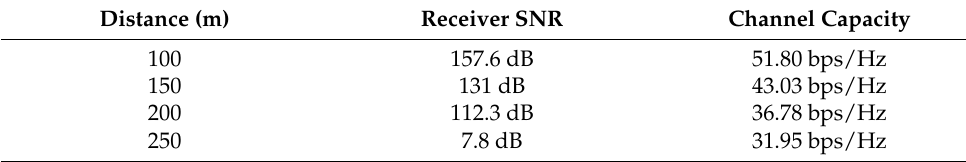
Figure 8. For 60 × 4, θ tilt = θ LoS , CDF of channel capacity at D = 100, 150, 200, 250 m. Table 5. For 60 × 4, θ tilt = θ LoS , simulation results at D = 100 m, 150 m, 200 m, 250 m. Distance